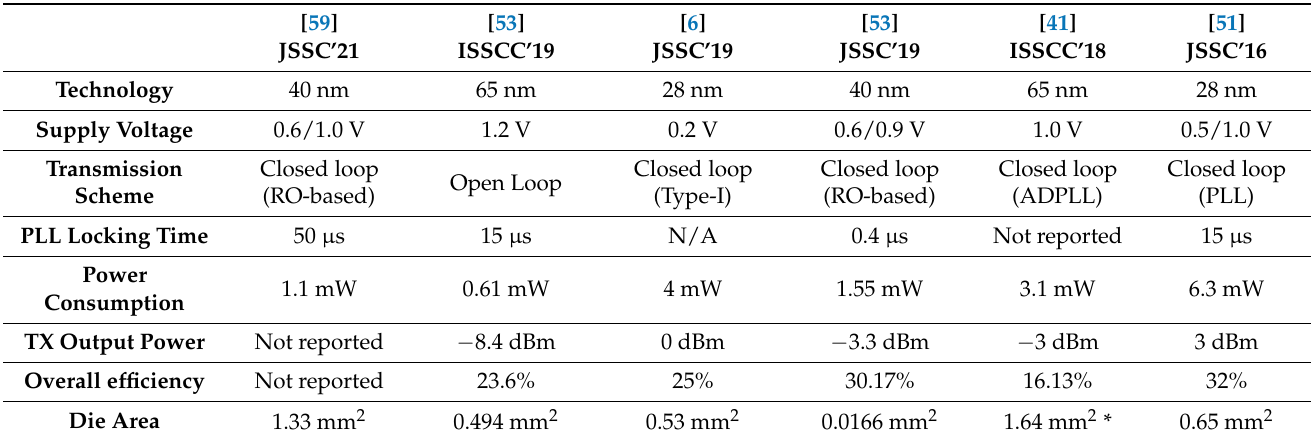
Table 2. Comparison table for the state-of-the-art Bluetooth-Low Energy